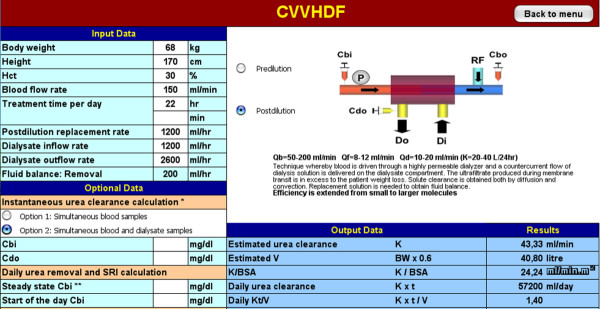
An Adequacy Calculator worksheet: continuous veno-venous hemodiafiltration (CVVHDF) is delivered in a 70 kg patient. Post-dilution mode is selected, machine settings and prescribed treatment time per day are entered on the upper left panel: estimated urea clearance (KCALC) and 'daily Kt/V' (spKt/VCALC) are displayed on the right. In the lower left panel it is possible to obtain KDEL measure after entering prefilter blood (Cbi) and effluent (Cdo) urea concentration: in this case, when operative times are entered, 'daily Kt/V' cell displays effectively delivered fractional clearance (spKt/VDEL).